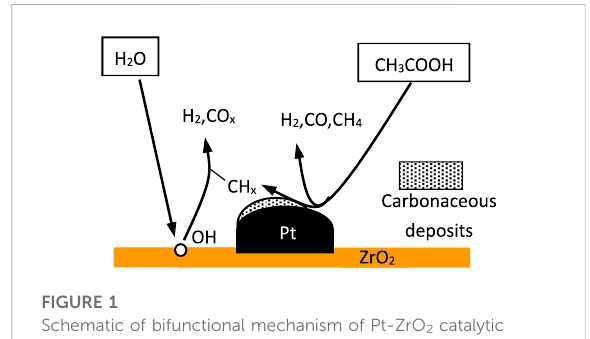
FIGURE 1 Schematic of bifunctional mechanism of Pt-ZrO 2 catalytic reforming of acetic acid for hydrogen